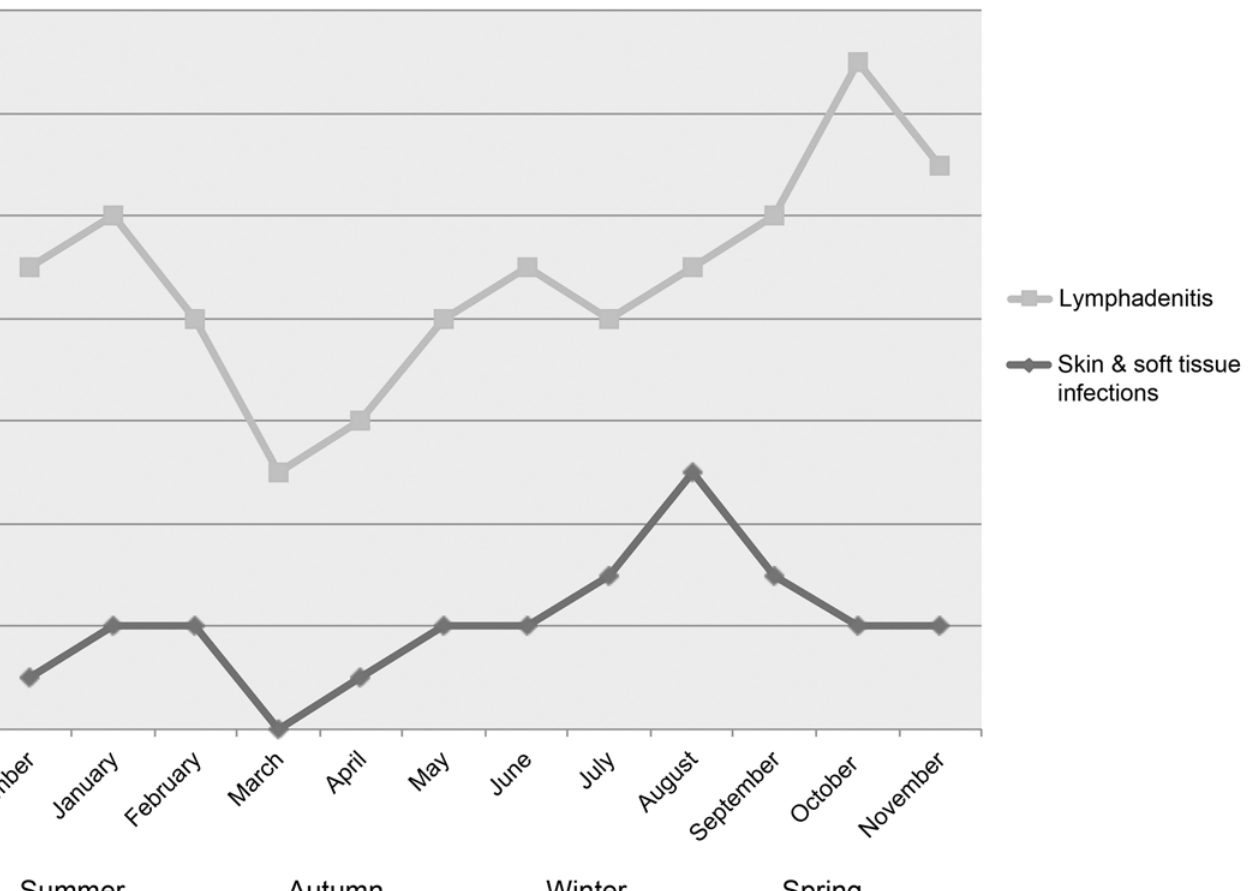
PLOS ONE | DOI:10.1371/journal.pone.0147513 January 26,